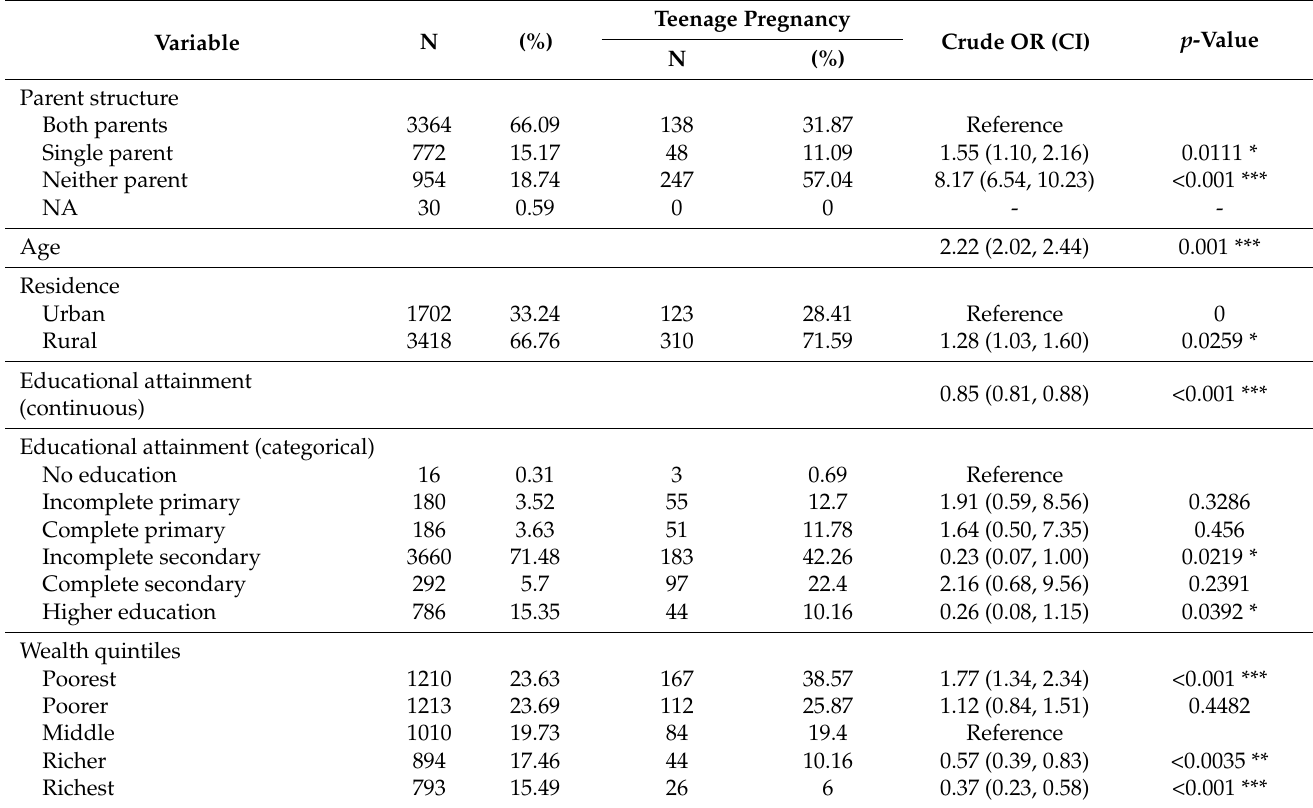
Table 2. Prevalence and the result of simple logistic regression of factors associated with teenage pregnancy by sociodemo- graphic